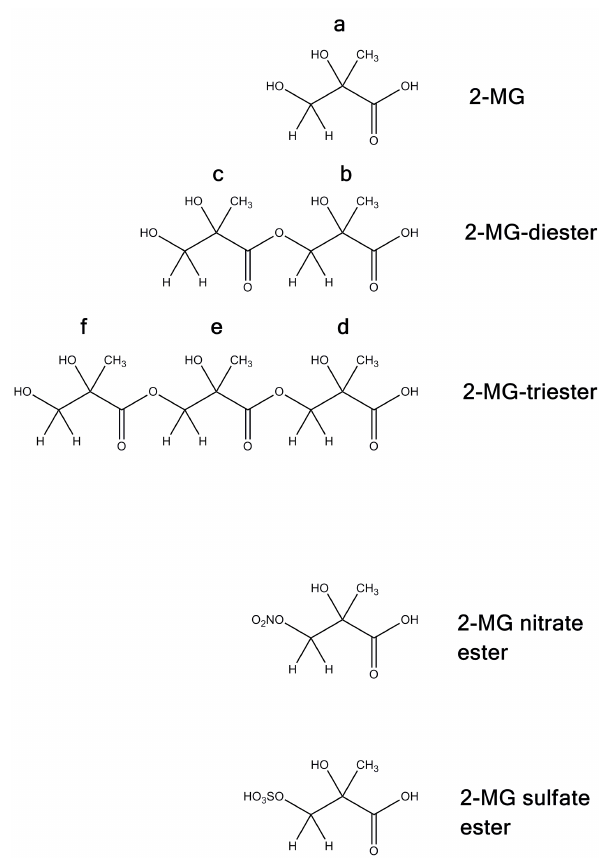
Fig. 3. Labels used for units of 2-MG (a) and associated species in NMR